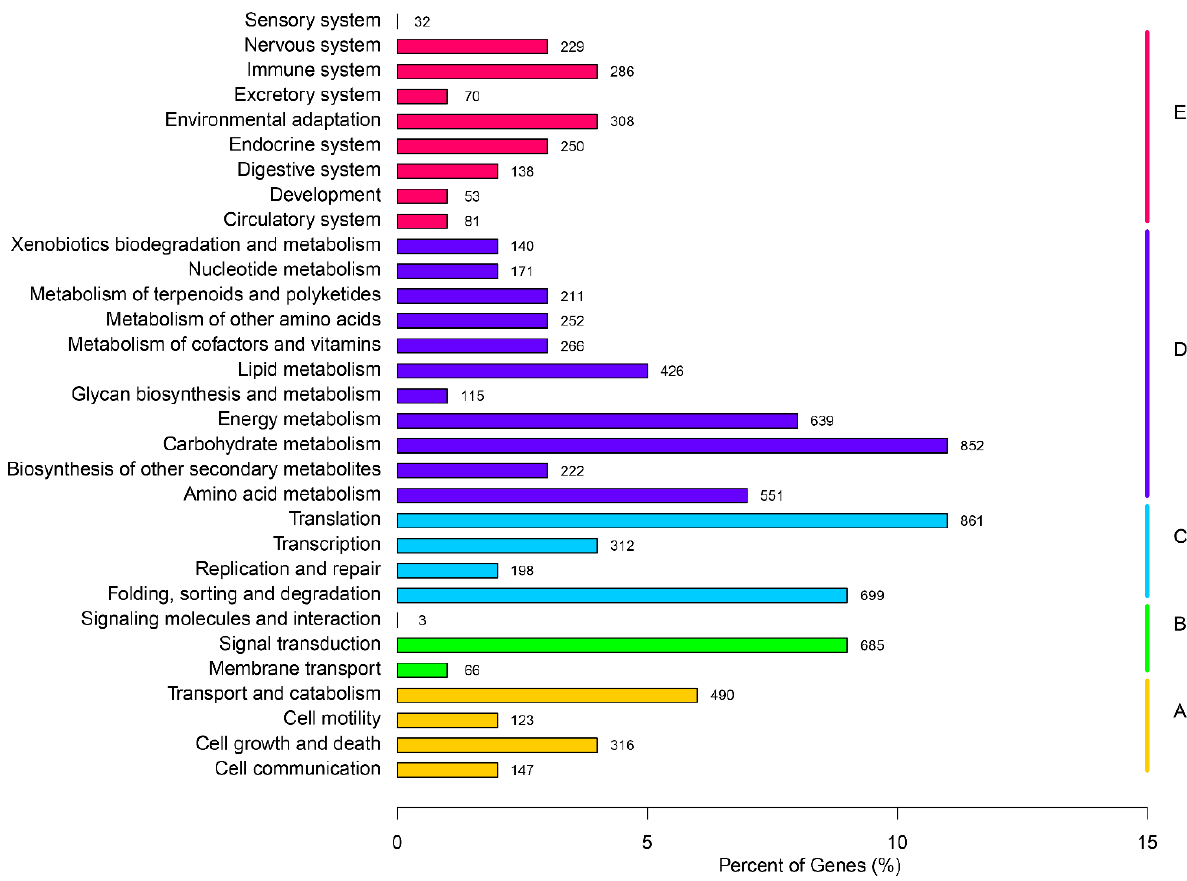
Figure 6. KEGG classification map. The ordinate is the name of the pathway, while the abscissa is the proportion of genes belonging to this pathway. These genes were divided into five branches: (A, Cellular Processes; B, Environmental Information Processing; C, Genetic Information Processing; D, Metabolism; E, Organismal Systems.) according to the metabolic pathway they participated